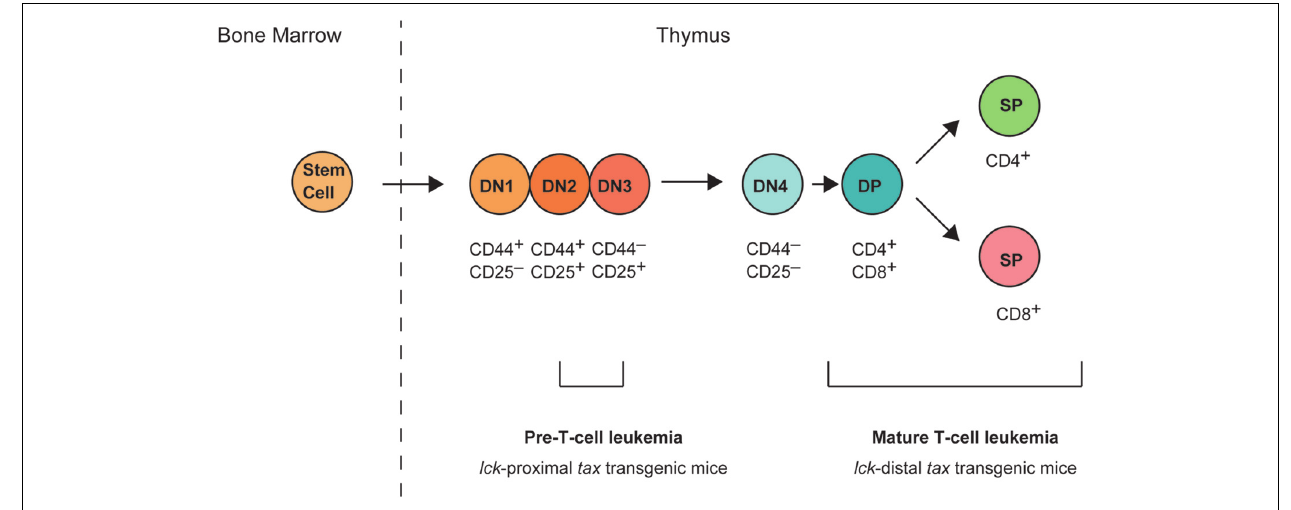
FIGURE 1 |T cell development in the thymus. Hematopoietic stem cells arise in the bone marrow and migrate to the thymus. Early committed T cells do not express CD4 or CD8, and are referred to as double-negative (DN; i.e., CD4 − or CD8 − ) thymocytes. DN thymocytes can be further subdivided into four stages of differentiation (DN1, CD44 + CD25 − ; DN2, CD44 + CD25 + ; DN3, CD44 − CD25 + ; and DN4, CD44 − CD25 − ). At the DN3 stage, DN cells express a pre-T cell receptor (TCR) and its surface